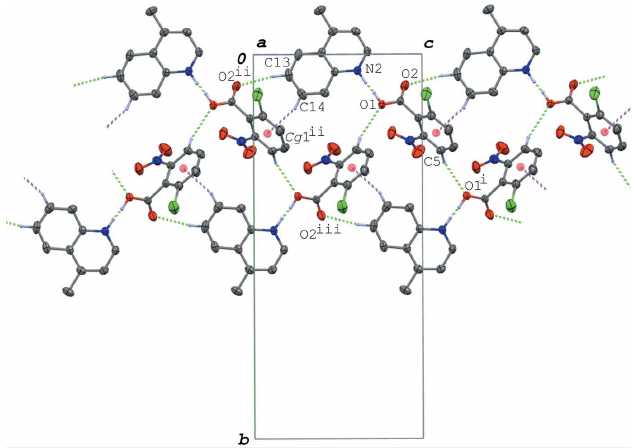
Figure 6 A partial packing diagram of (III) viewed along the a axis, showing the ribbon structure formed by the O—H (cid:2)(cid:2)(cid:2) N/O (cid:2)(cid:2)(cid:2) H—N and C—H (cid:2)(cid:2)(cid:2) O hydrogen bonds (green dashed lines), and C—H (cid:2)(cid:2)(cid:2) (cid:2) interactions (magenta dashed lines). H atoms not involved in the intermolecular interactions and the disordered O atoms of the minor component of the nitro group are omitted for clarity. [Symmetry codes: (i) x , (cid:3) y + 1 , z + 1 ; 2 2 (ii) x , y , z (cid:3) 1; (iii) x , (cid:3) y + 1 , z (cid:3) 1 .] 2 2